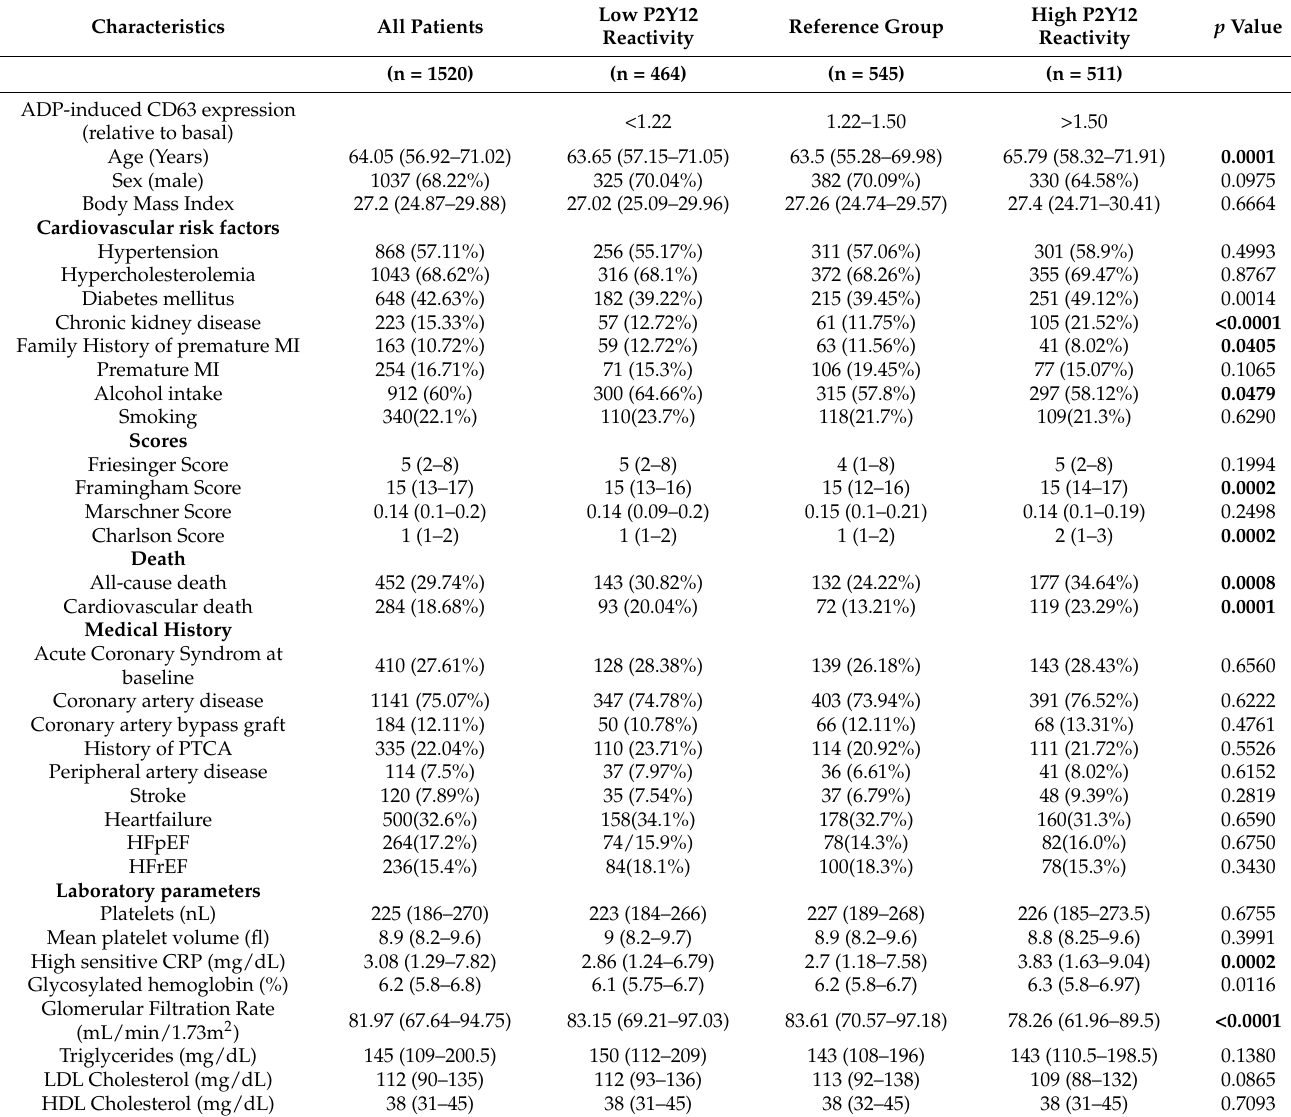
Table 1. Patient characteristics stratified by platelet